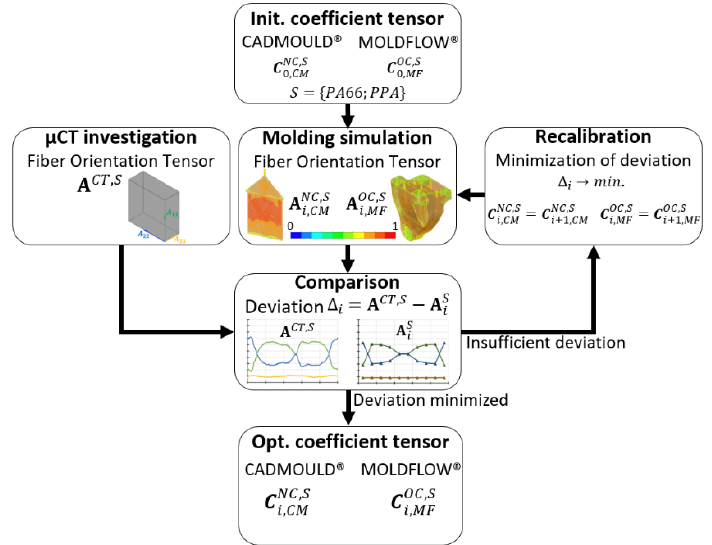
Figure 3. Proposed approach for calibrating and comparing the calculated fiber orientation of injection molding simulations to experimental µCT investigations.